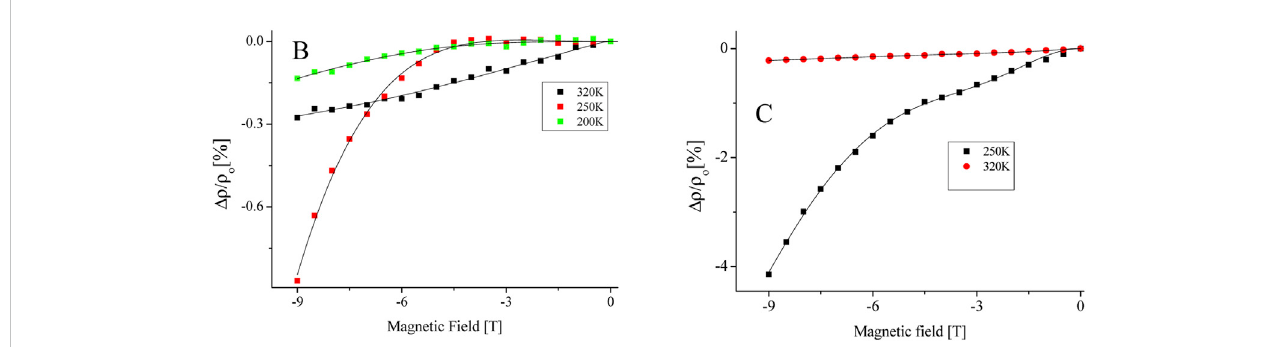
FIGURE 9 Khosla and Fisher model equation selectively (-9T-0T) fi tted on experimental data of magnetic fi eld dependence of MR for samples (B, C) , which are showing negative MR values.